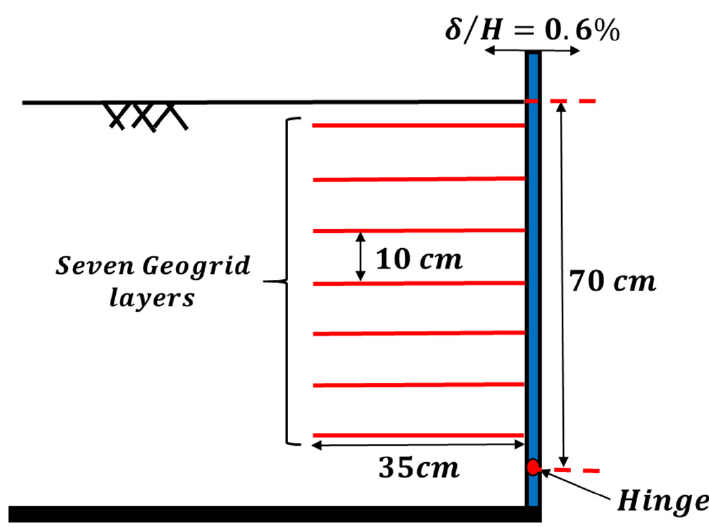
Figure 6. Schematic view of test with details.